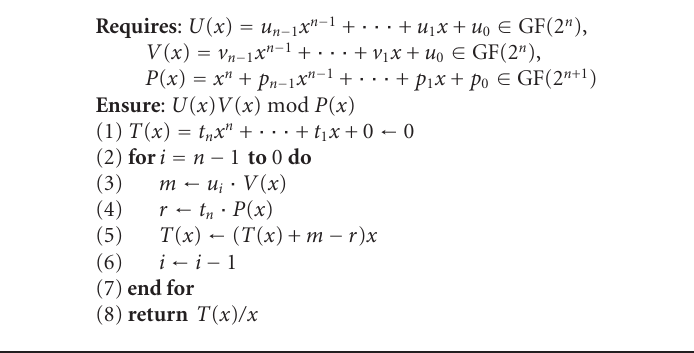
Algorithm 1: GF multiplication of U · V mod P by adding n times.